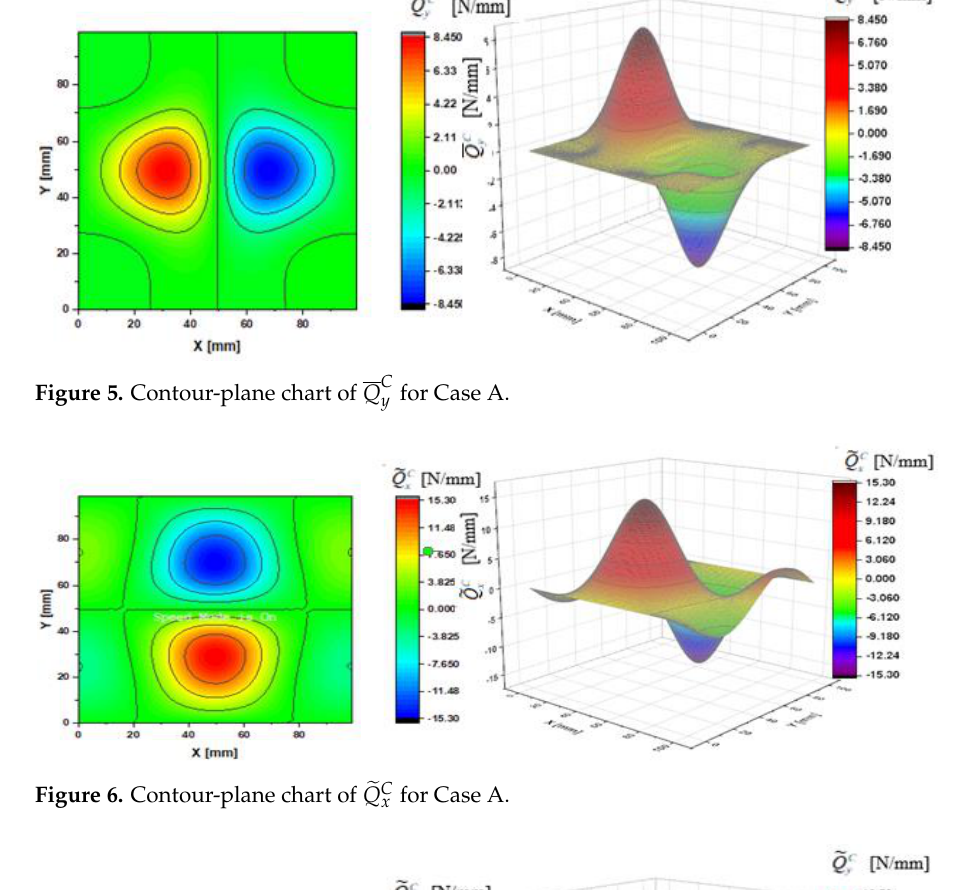
Q ~ for Case A. Q ~ for Case A. x Q ~ for Case A. x x